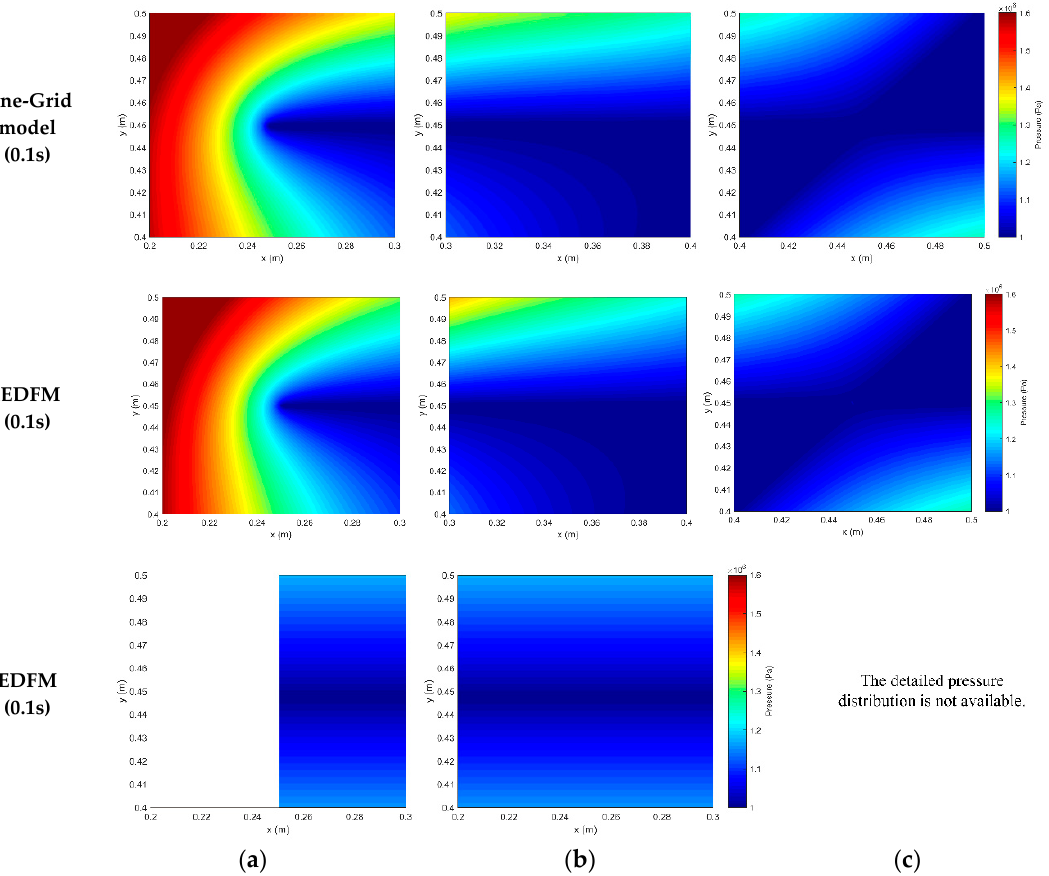
Figure 6. Pressure distribution profiles after 0.1 s pumping of the fine-grid model/iEDFM (assumed)/EDFM (assumed) for block ( a )/( b )/( c ).